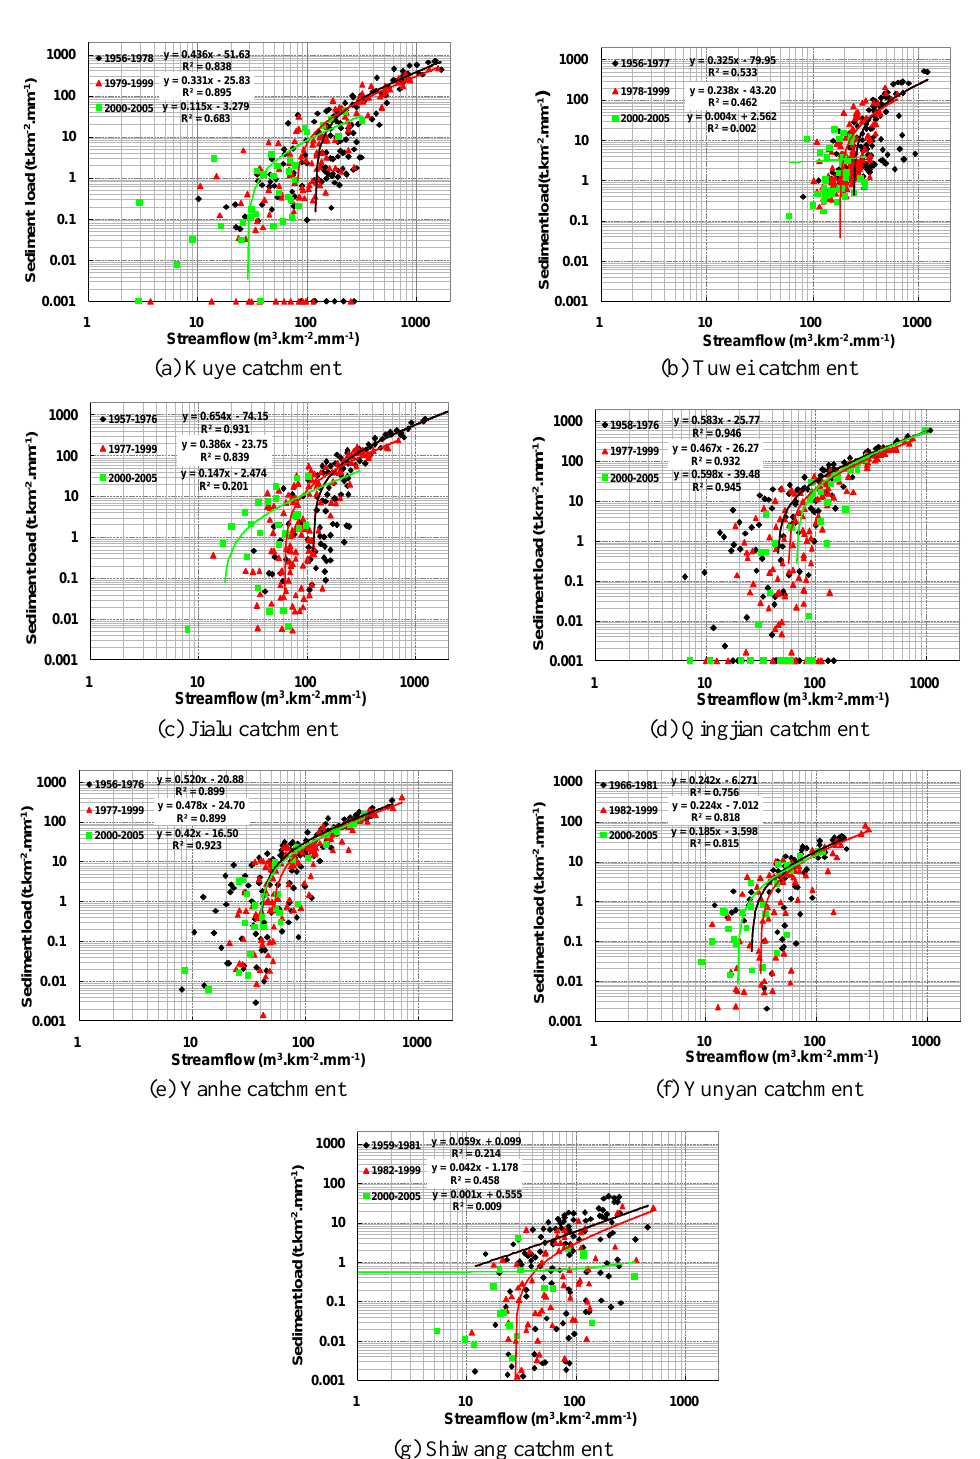
Fig. 3 The scattered distributions and simple linear regressions for monthly standardized streamflow and standardized sediment load from May to October in three periods in seven catchments. Streamflow is with unit of m 3 km − 2 mm − 2 , and sediment load, tkm − 2 mm − 1 . It is log transition both in X- and Y-axis. Plots (a) , (b) and (c) represent the scattered distribution for the three transition zone catchments; plots (d) and (e) , for the two loess hilly-gully catchments; and plots (f) and (g) , for the two rocky mountain